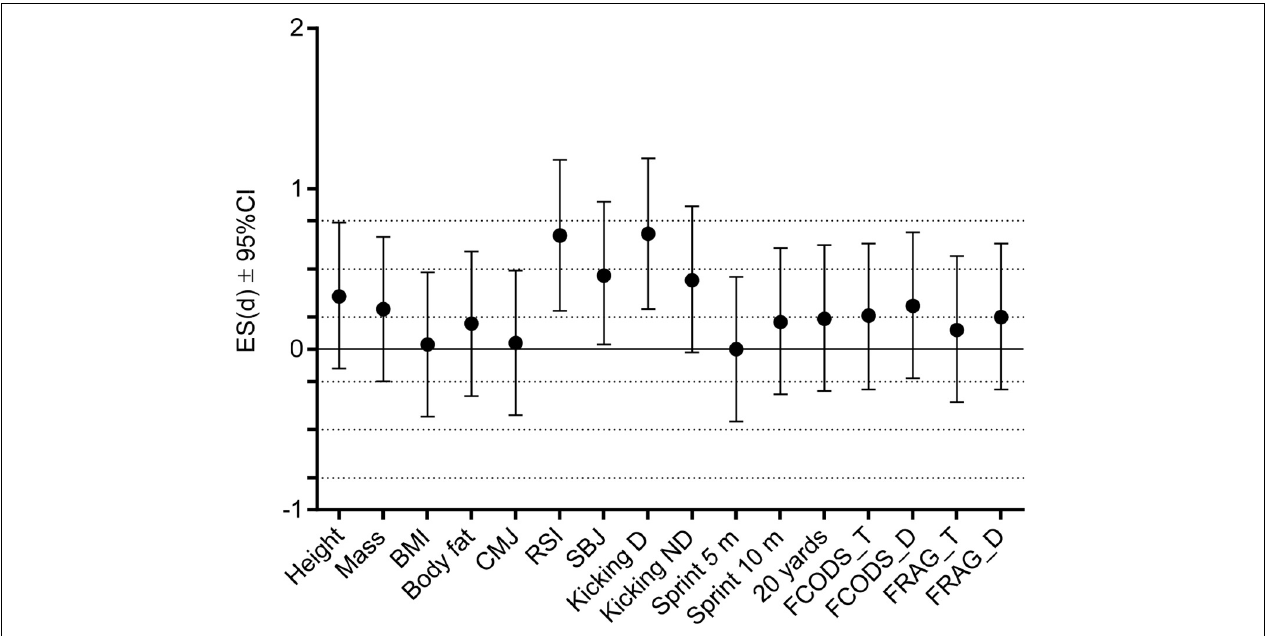
FIGURE 2 | Effect size differences between starters and non-starters in studied anthropometric and physiological variables. CMJ, countermovement jump; RSI, reactive strength index; SBJ, standing broad jump; Kicking D, kicking speed dominant leg; Kicking ND, kicking speed non-dominant leg; 20 yards, generic change of direction speed test over 20 yard distance; FCODS_T, futsal specific change of direction speed test without dribbling; FCODS_D, futsal specific change of direction speed test with dribbling the ball; FRAG_T, futsal specific reactive agility test without dribbling; FRAG_D, futsal specific reactive agility test with dribbling the ball. Dashed lines present ES ranges ( < 0.02 = trivial; 0.2–0.6 = small; > 0.6–1.2 = moderate; > 1.2–2.0 = large differences).